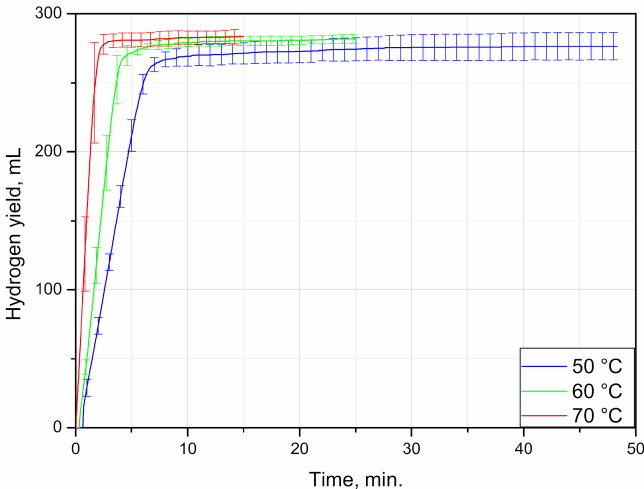
Figure 5. Kinetic curves for PA–PE–Al sheets under different